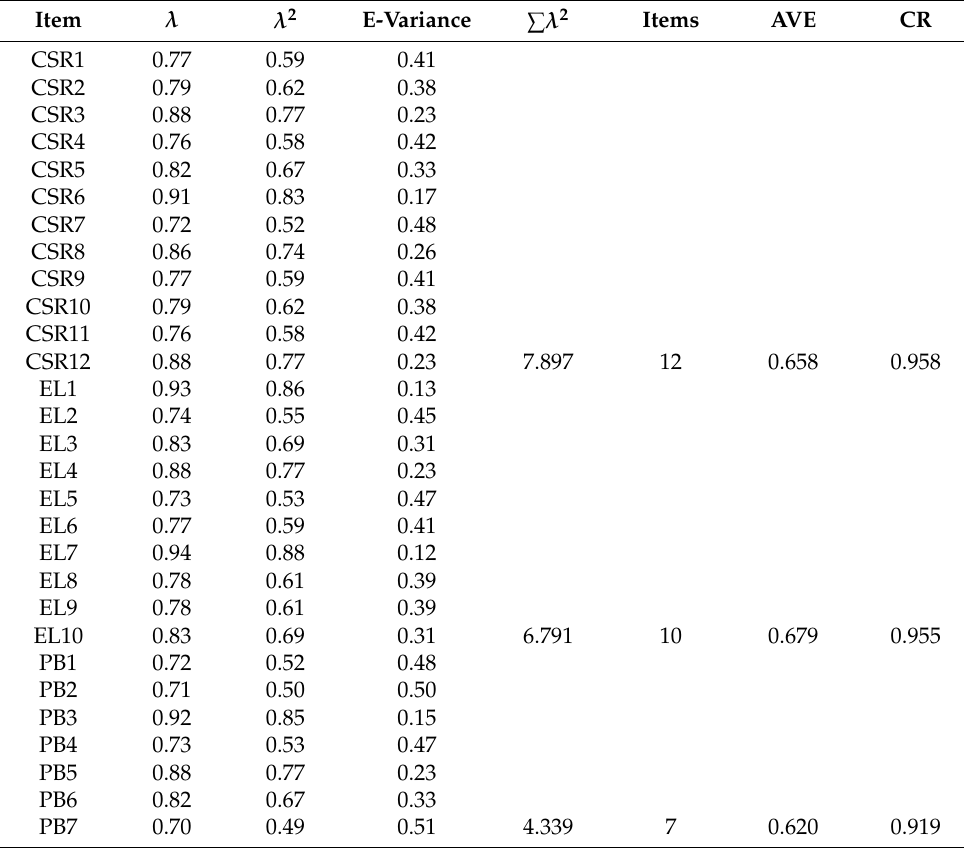
Table 3. Factor loadings, convergent validity, and composite